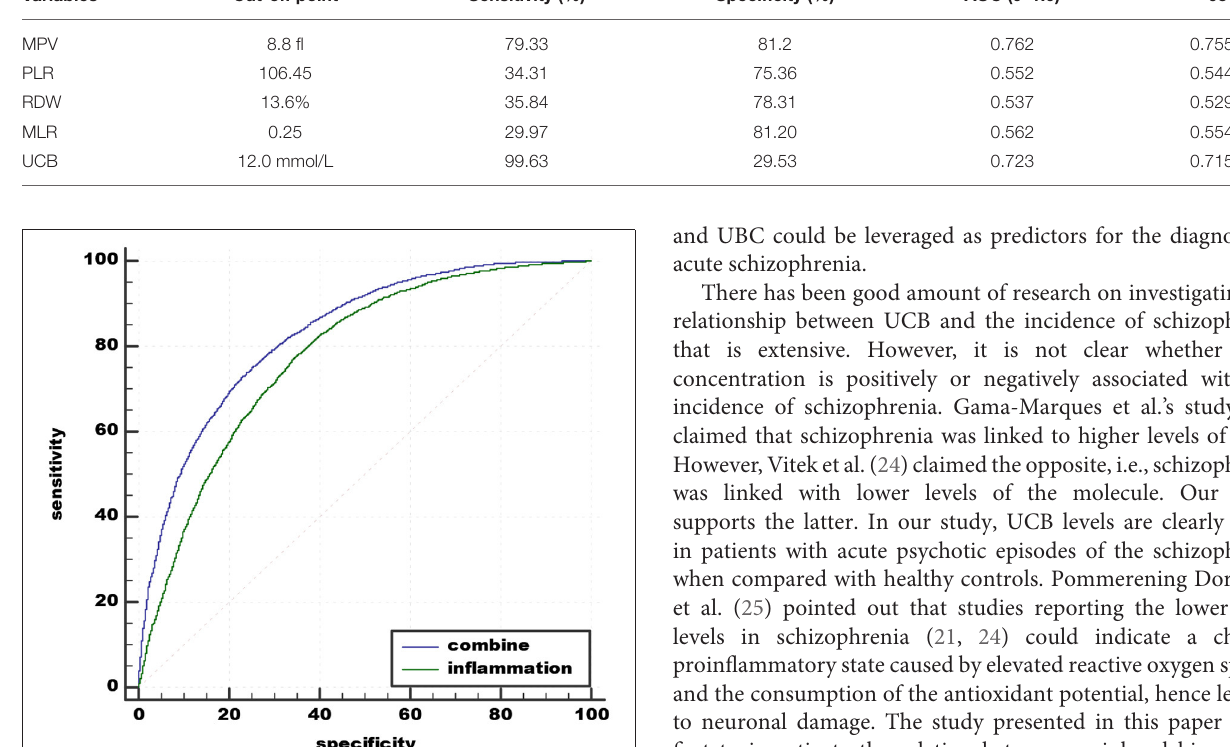
sensitivity 77.38% and specificity 65.57% (AUC 0.779, 95% CI 0.772–0.786). The recommended cut-off value for the combined value based on the maximum of Youden’s index on the ROC curve was 0.53126 and it exhibits 73.01% sensitivity and 76.87% specificity in the prediction (AUC 0.831, 95% CI